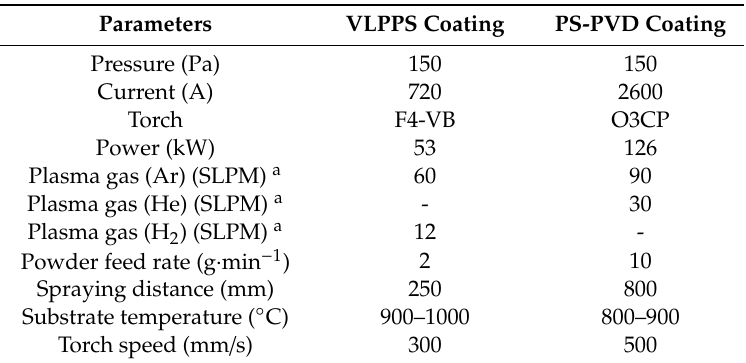
Table 2. Parameters of the very-low-pressure plasma spray (VLPPS) and plasma spray–physical vapor deposition (PS-PVD).